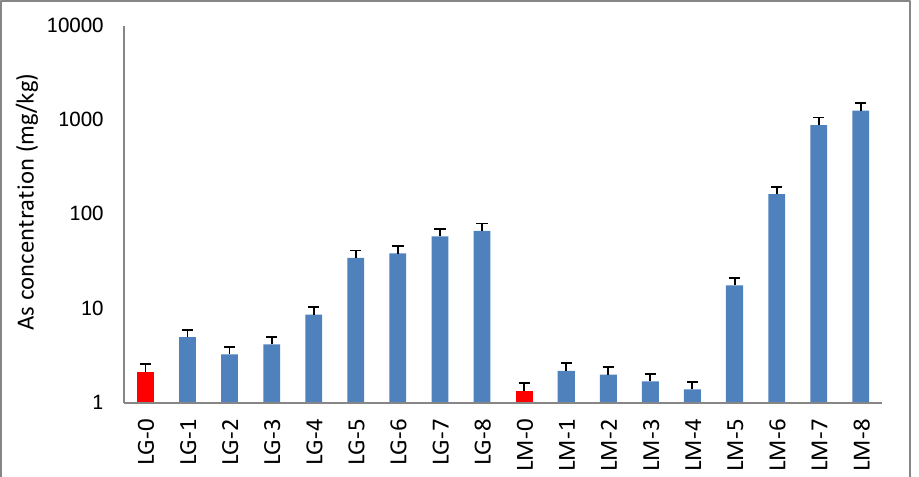
Figure 5. As accumulation ratios by L. gibba and L. minor . Despite the high concentrations of arsenic (193 µg L − 1 ) in the acid mine water of the study area, L. gibba and L. minor removed As from 355 L and 6496 L of water, respectively, by the end of the 8-day experiment.